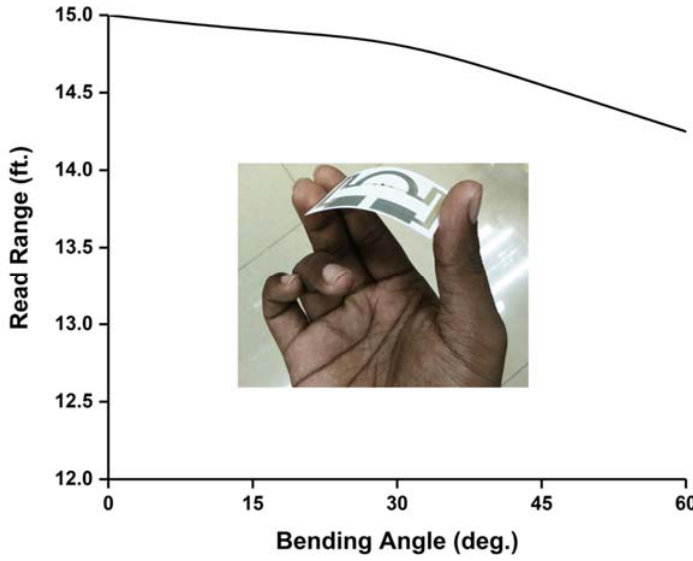
Figure 8. Read range analysis for different bending conditions. Table 2. Comparison with some existing works.